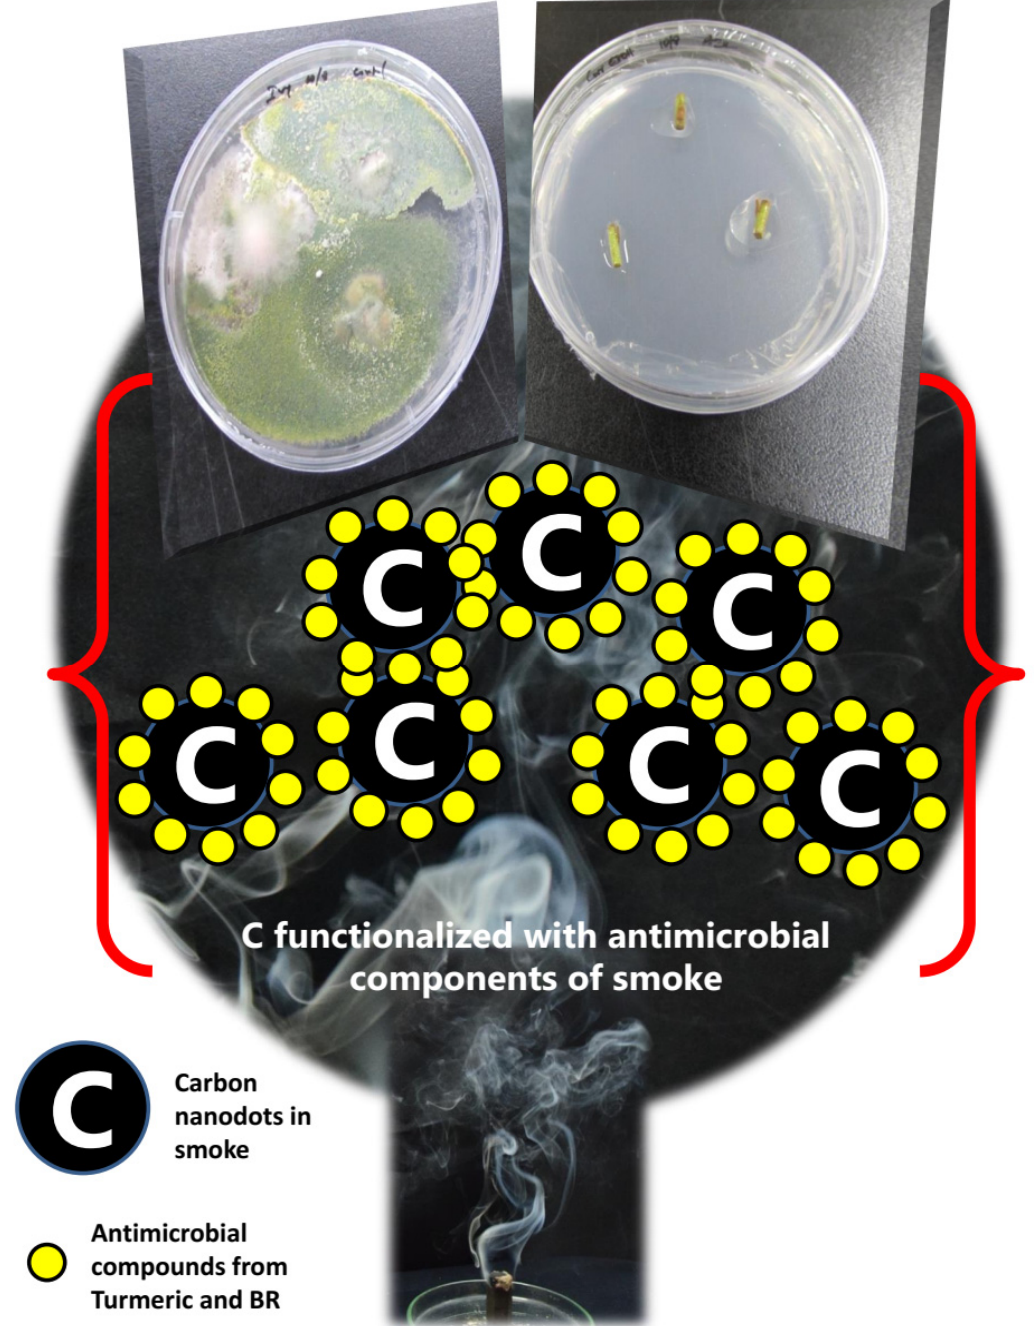
Figure 6. Cartoon speculating the mechanism of fumigation-based surface